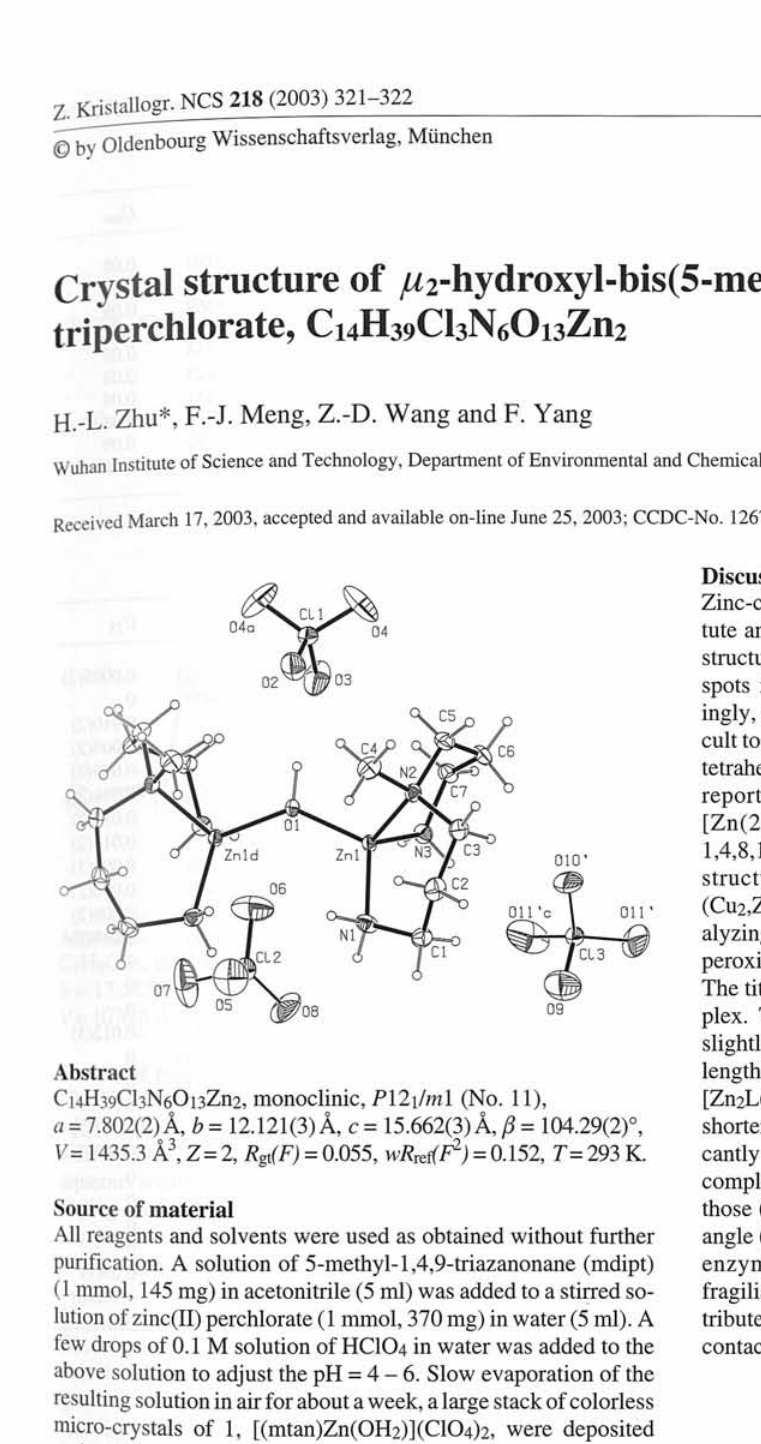
Table 1. Data collection and handling.